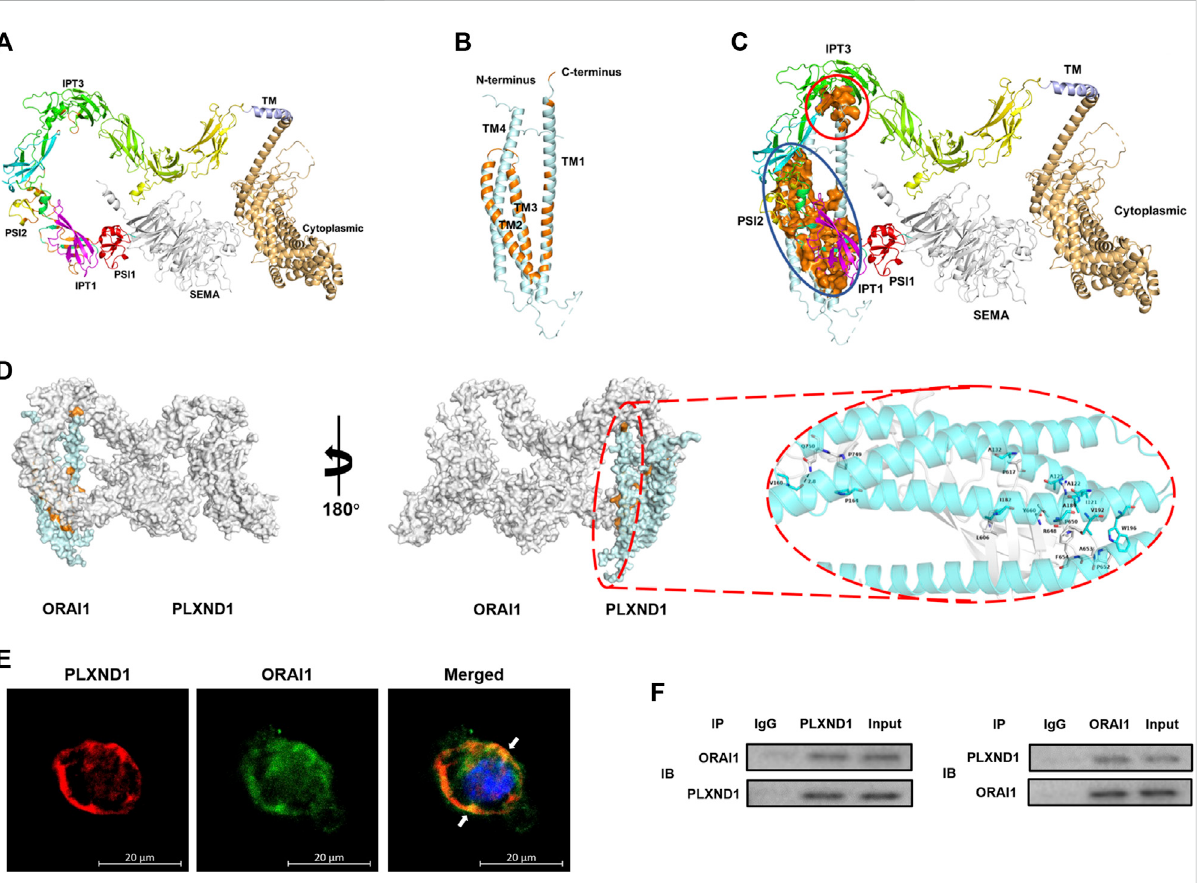
FIGURE 4 PLXND1 binds to ORAI1 in endocardial endothelial cells to regulate intracellular calcium levels. (A – B) Structure of predicted PLXND1 (A) and ORAI1 (B) . The elements of secondary structure ( α -helices and β -sheets) are represented by different colors. (C) Schematic visualization of the PLXND1-ORAI1 complex, and the coupling regions were marked by red and blue solid circle respectively. (D) Three-dimensional structure showing PLXND1-ORAI1in (C) .PLXND1andORAI1arerepresentedasthegreyandblueribbonrespectively.Aviewrotated180 ° aboutthe y axisisshown with the enlargement of interact surface in red solid circle (right). (E) Immuno fl uorescent staining was applied to mark PLXND1 (red) and ORAI1 (green)inEECs.White arrows representtheir colocalization on theEECs.Scalebar:20 μ m. (F) LysatesfromEECsweresubjectedtoIPwith IgG,anti- PLXND1, or anti-ORAI1 antibody, followed by western blotting for PLXND1 and ORAI1. PLXND1, plexinD1; EECs, endocardial endothelial cells; IP, immunoprecipitation; IB, immunoblotting; NC, negative control; WB, western